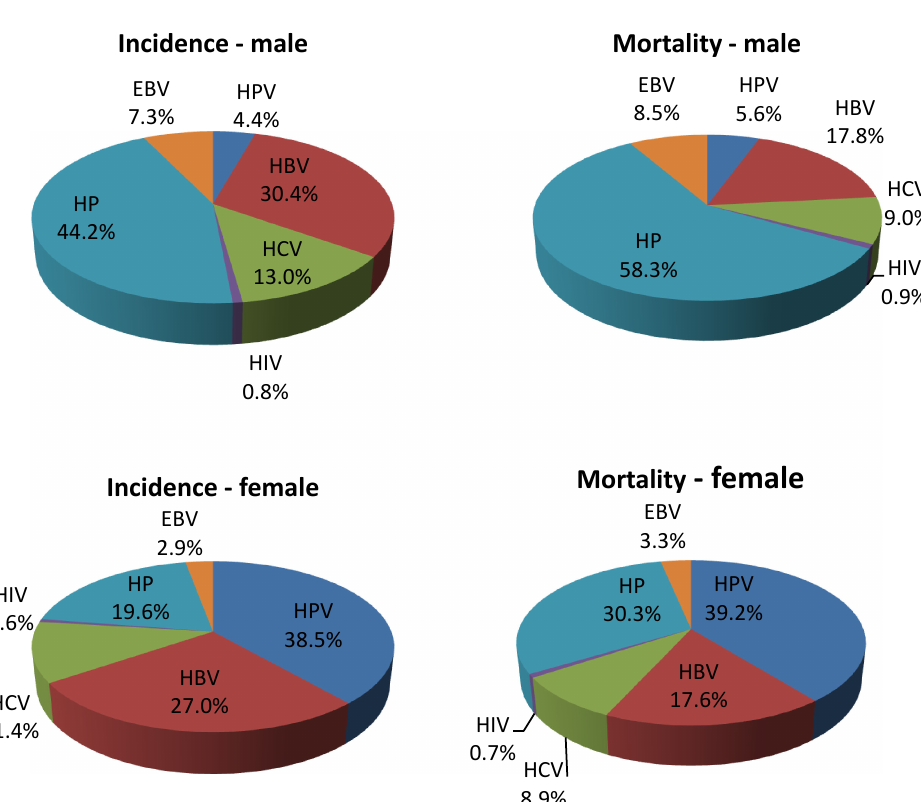
Figure. Proportion of estimated new cancer cases and deaths attributable to different infectious agents in men and women.